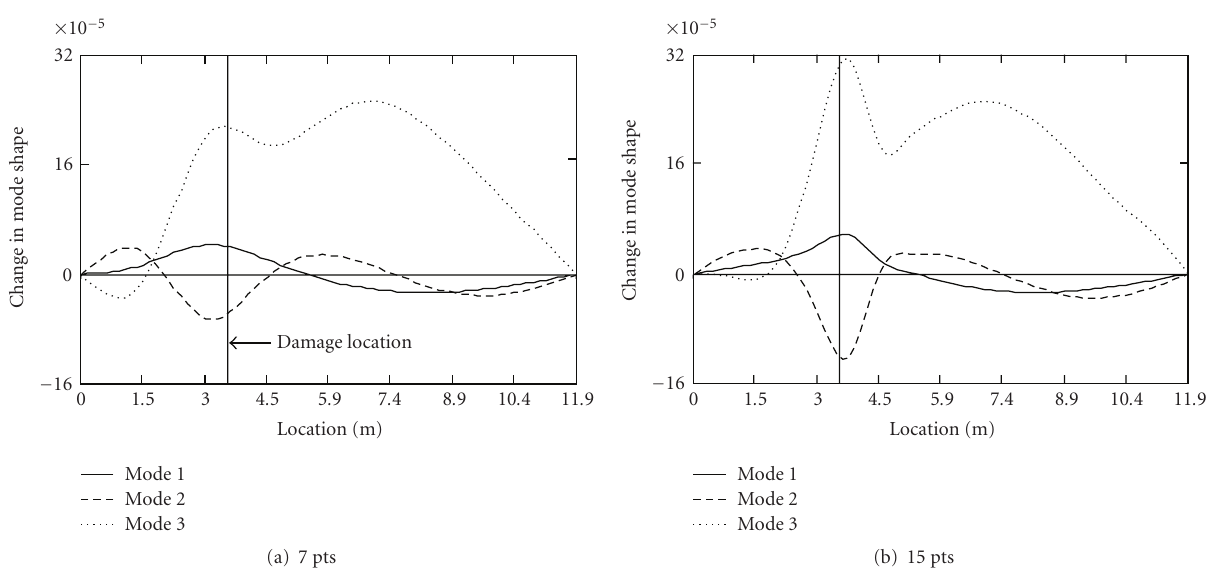
Figure 13: Changes in the first three flexural mode shapes caused by numerical damage case 24, located 3.50 m from the support, calculated using (a) 7 and (b) 15 simulated measurement points.